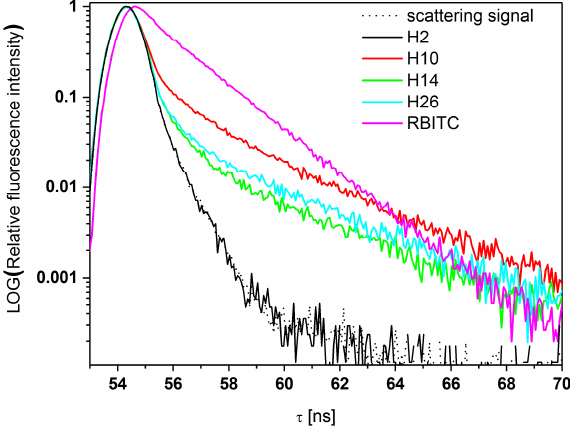
Figure 11. Fluorescence time decays of investigated samples.